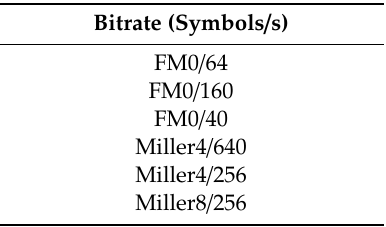
Table 1. Backward link six